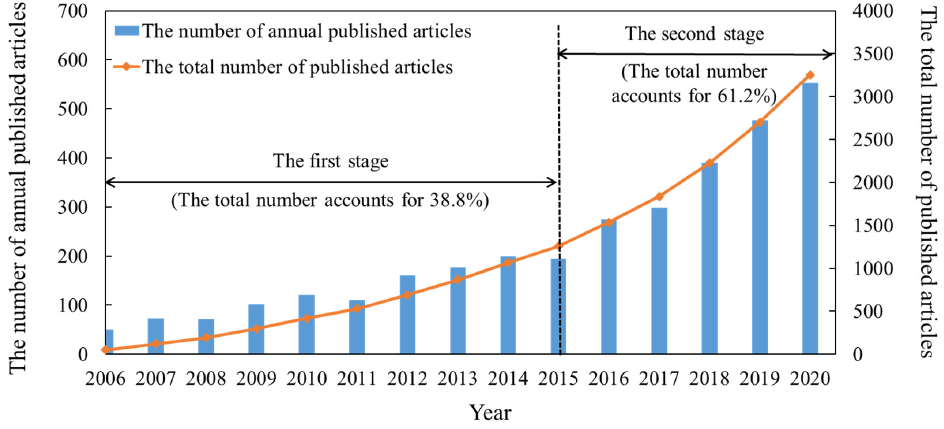
Figure 2. The trends of published articles in the urban floods field during